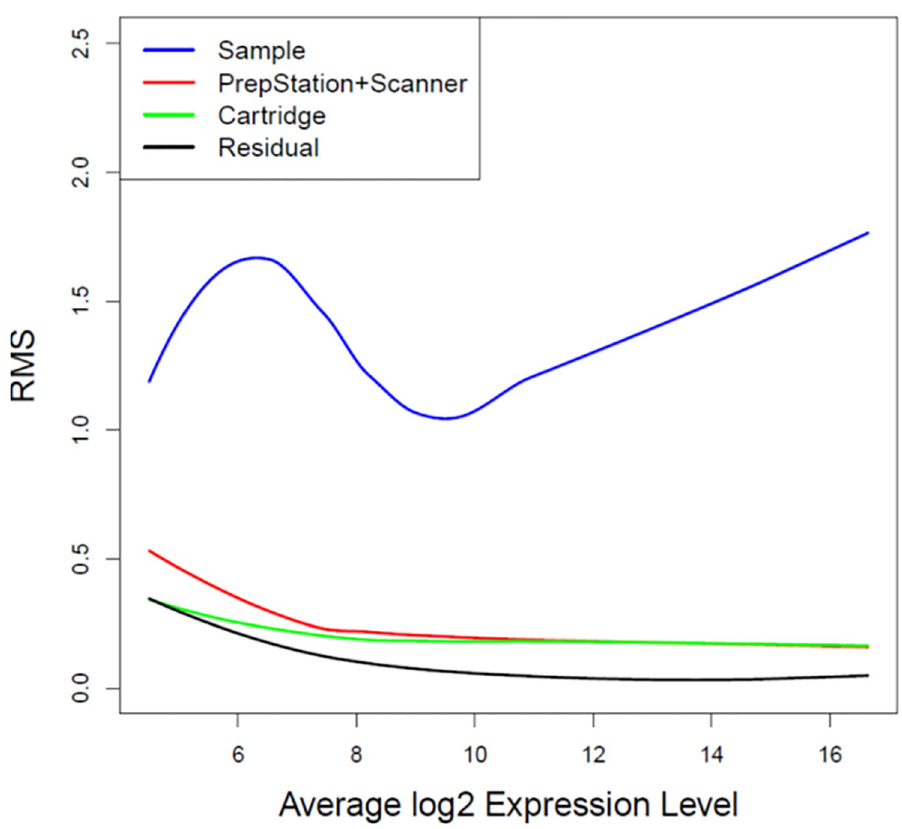
Fig 4. LOESS curve fitting of RMS against average expression levels for the comparison at the second time scan. Variance components of ANOVA models were smoothed over average log2 expression levels through LOESS fit. Blue curve represents variability of biological samples. Red curve represents variability of PrepStation and scanners. Green curve represents variability of cartridges. Black curve represents variability of residual errors.